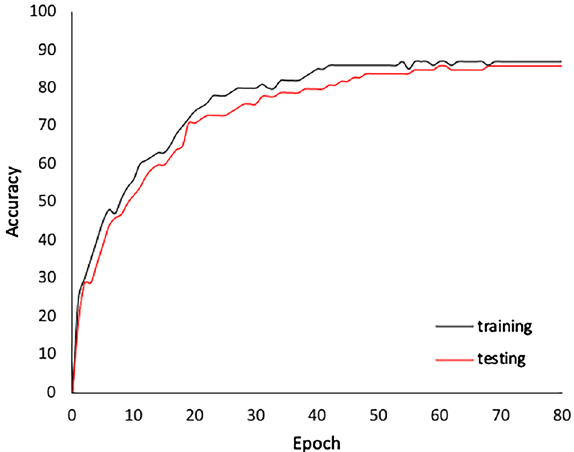
Figure 8. Training and testing accuracy of the network used in the proposed semi-supervised approach.